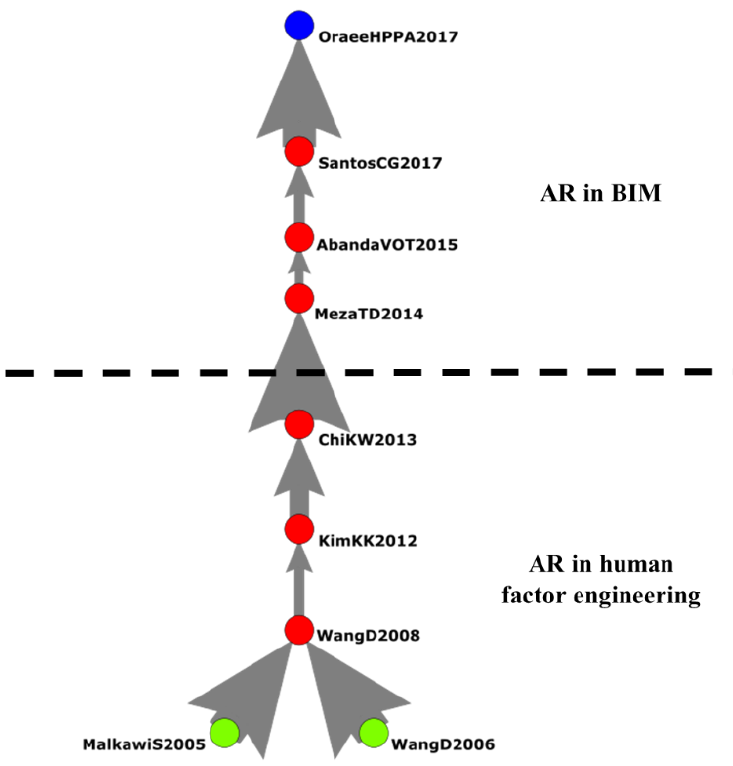
Figure 9. Application of AR technology in architecture.